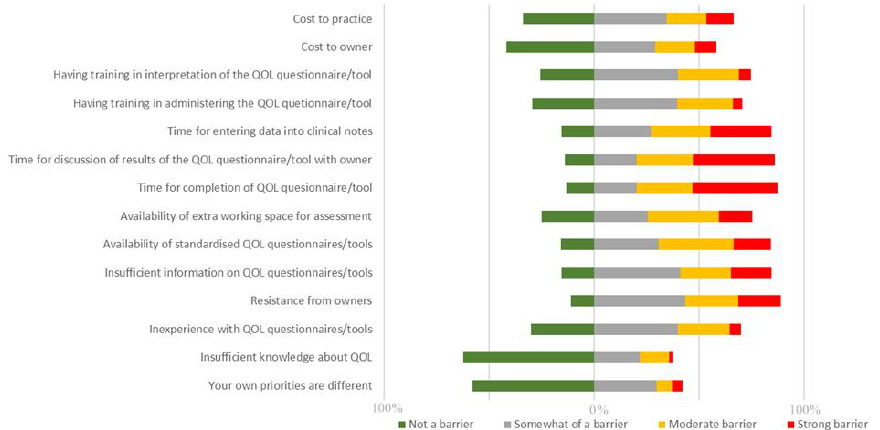
Figure 1. Diverging bar chart showing the percentage of veterinary professionals rating each barrier to the use of quality of life (QOL) assessment tools on a likert-type scale.